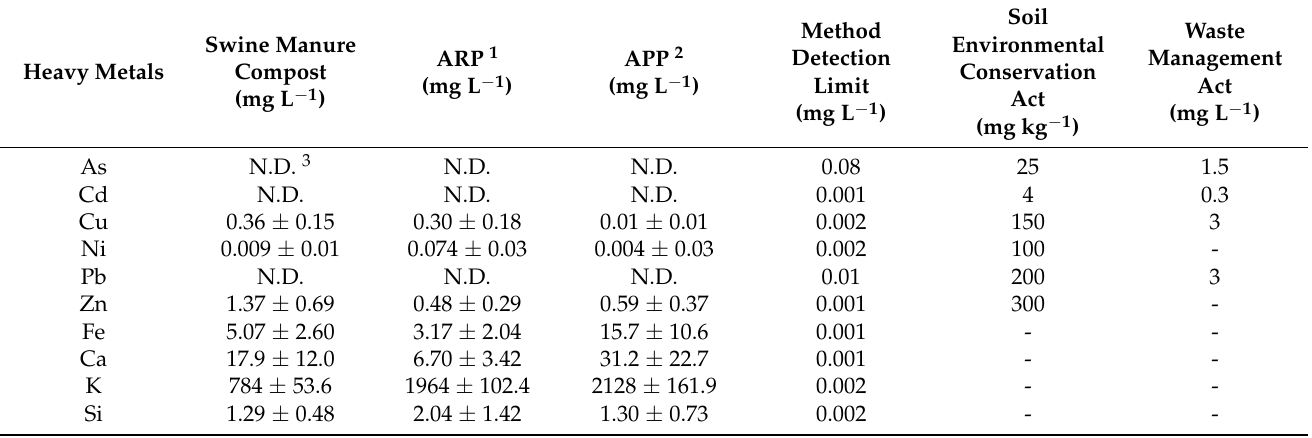
Table 4. Heavy metals and light metals concentration (mean ± standard deviation, n = 3) in the leachates from swine manure compost and